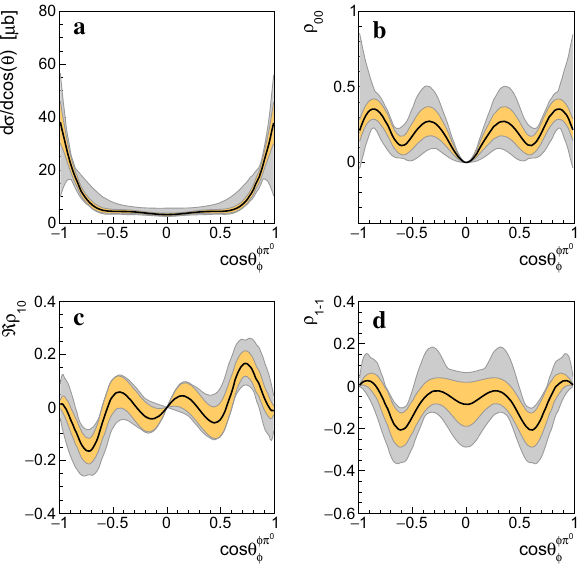
Fig. 17 Differential production cross section ( a ) and spin density matrix elements ρ 00 ( b ), (cid:13) ρ 10 ( c ) and ρ 1 − 1 ( d ) of the φ( 1020 ) in ¯ pp → φ( 1020 )π 0 . All elements are shown in the helicity system of the φ( 1020 ) . The yellow and the gray bands stand for the statistical and systematic uncertainty, respectively